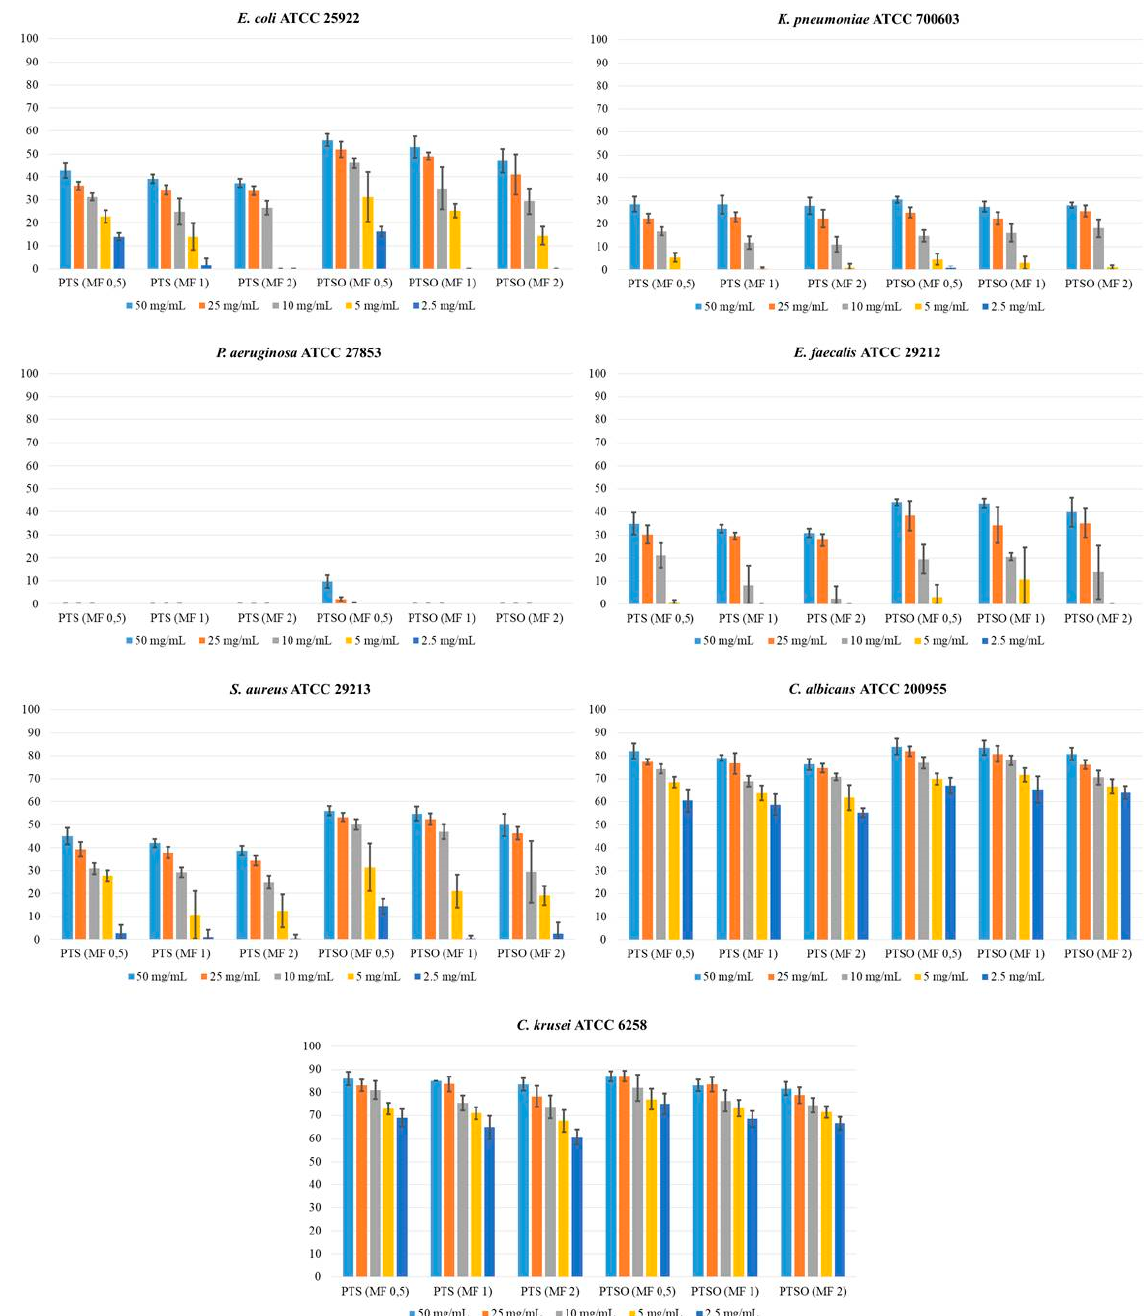
Figure 2. Average value ± standard deviation (in mm) of the growth inhibition halos for each concentration of PTS and PTSO, in the different inocula (0.5, 1, and 2 of McFarland) and for the different microorganisms. Diameters from the inhibition of growth zones were directly related to the concentration of PTS or PTSO used, and inversely related to the microbial inoculum used. Greater halos were observed in the case of yeasts. The diameters of the growth inhibition halos produced via the gas phase of PTSO were significantly larger than those obtained from PTS.